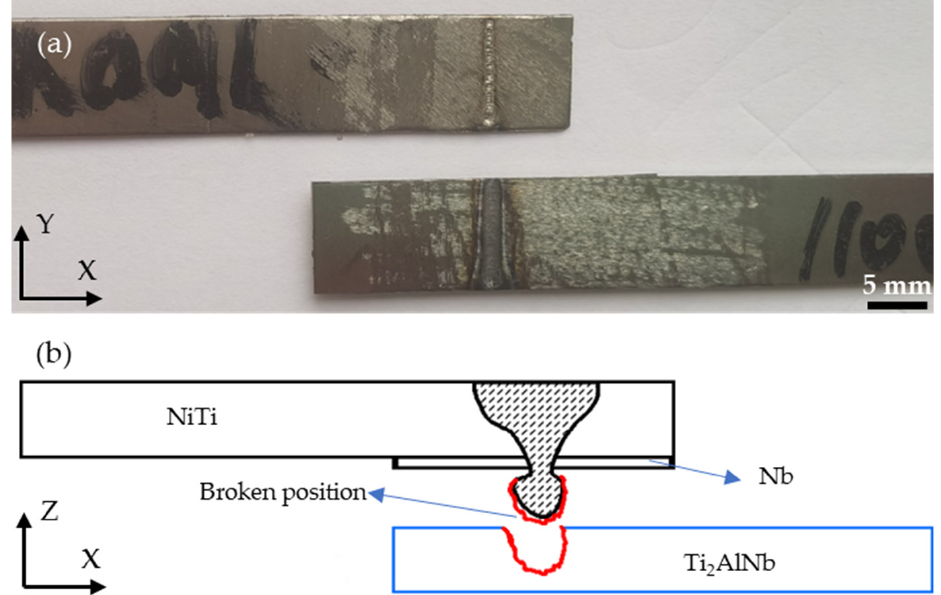
Figure 9. Fracture mode I: ( a ) Tensile fracture specimen; ( b ) Schematic diagram of fracture (The red line indicates the fracture surface).